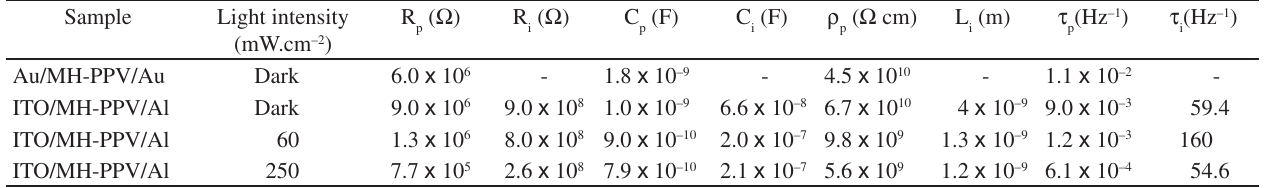
Table 1. Data of fittings between Equation 2 and experimental results for Au/MH-PPV and ITO/MH-PPV/Al exposed to different light intensities. For all fitting it was obtained α = α = 0.98 and R ~ 30 Ω P I ITO